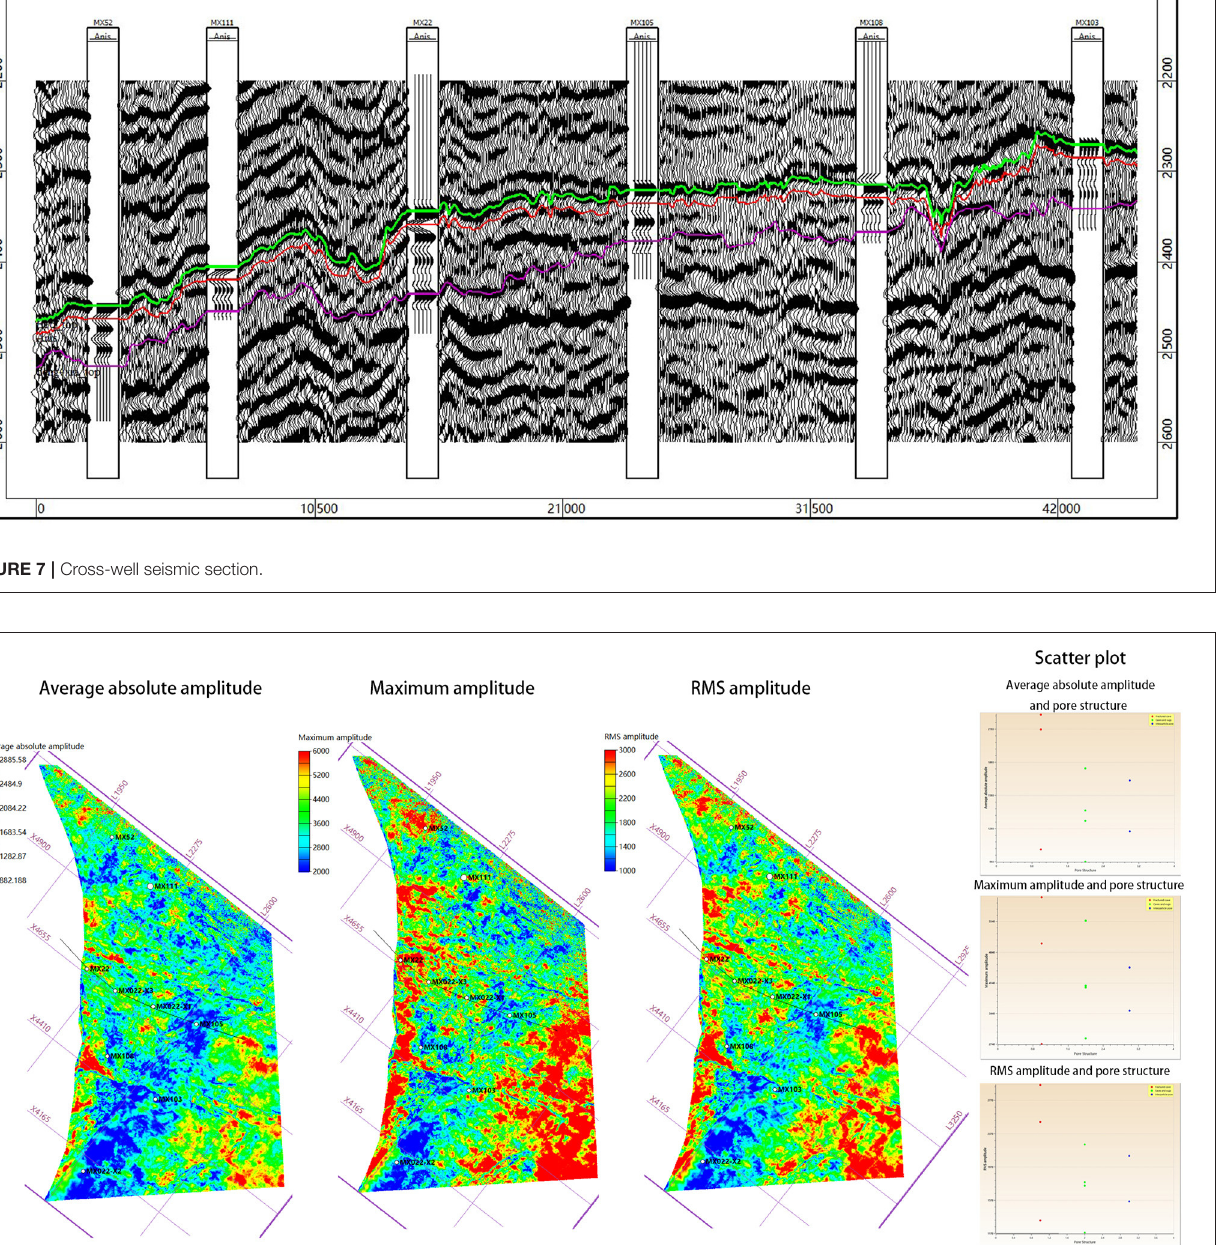
LOG CALIBRATION Data from five wells in the study area are used to verify the observed theoretical model results. The resistivity scan image log is first used to determine the formation pore type ( Table 2